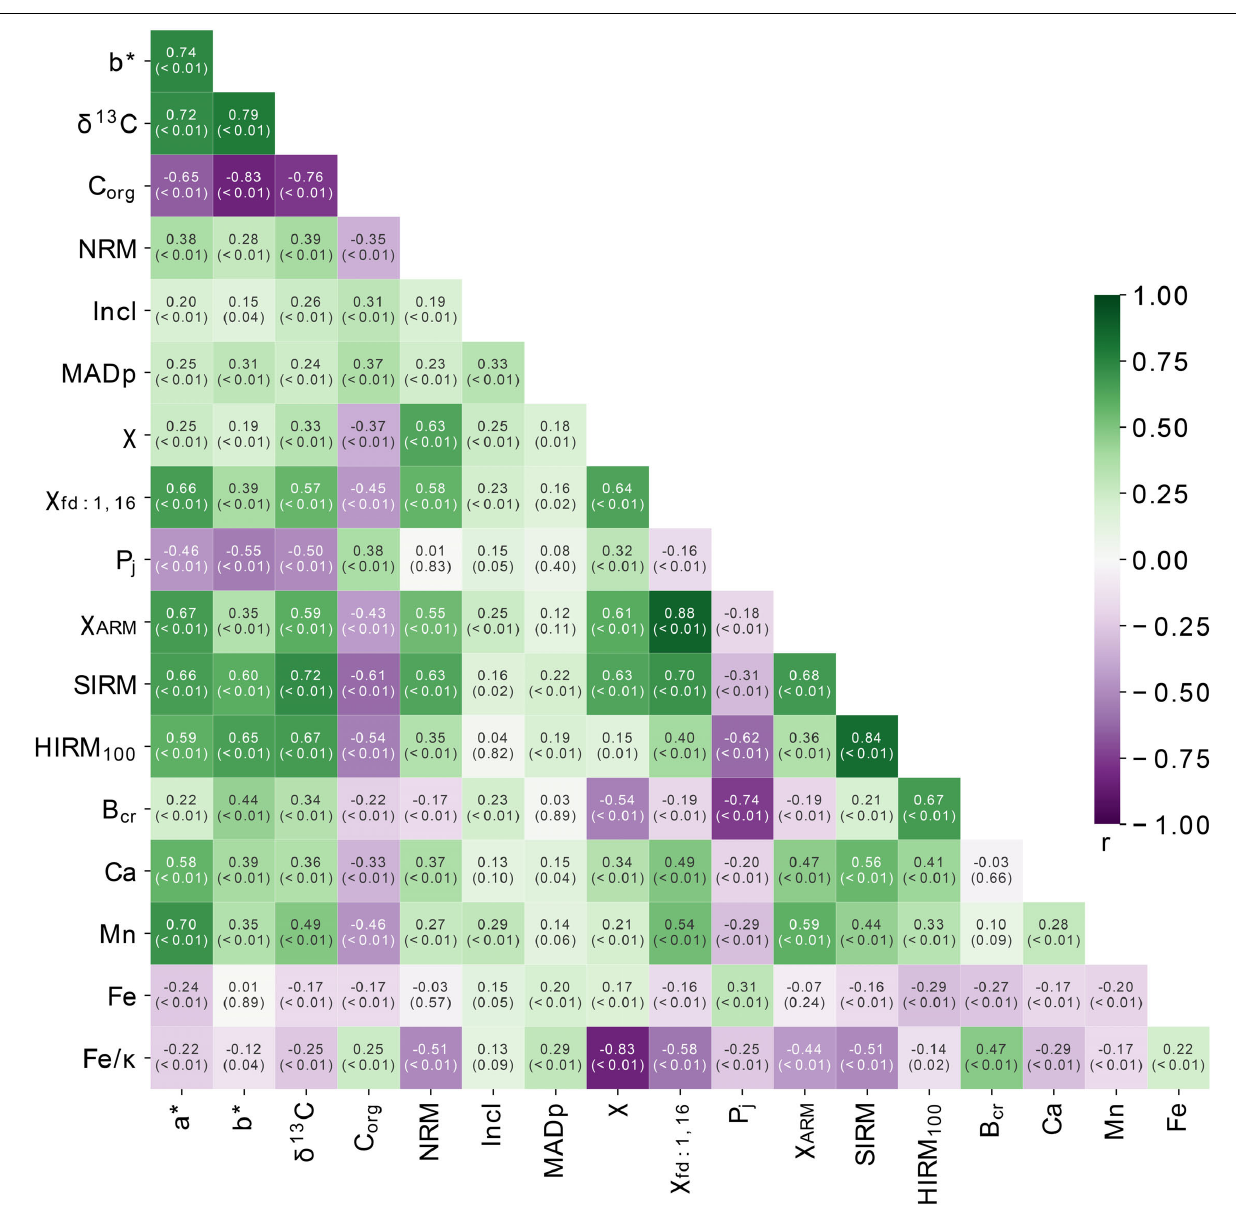
FIGURE 9 | Correlation matrix of physical, chemical, palaeomagnetic and rock magnetic properties of SWERUS-13PC (13PC). Pearson correlation coefficients ( r ) are displayed as numbers and colour by value, numbers in brackets are p -values for each correlation. Parameters are: green-red (a*) and blue-yellow (b*) colour components, total organic carbon (C org ), stable carbon isotopes ( δ 13 C), natural remanent magnetisation (NRM), characteristic remanent magnetisation inclination (Incl), median angular deviation (MAD p ; prolate), mass normalised magnetic susceptibility ( χ ), frequency dependent magnetic susceptibility ( χ fd : 1 , 16 ), degree of anisotropy (P j ; magnetic fabric), susceptibility of anhysteretic remanent magnetisation ( χ ARM ), saturation isothermal remanent magnetisation (SIRM), hard isothermal remanent magnetisation (HIRM 100 ; from 100 mT backfield), coercivity of remanence (B cr ), calcium (Ca), manganese (Mn), iron (Fe) and the ratio of iron to volume magnetic susceptibility (Fe/ κ